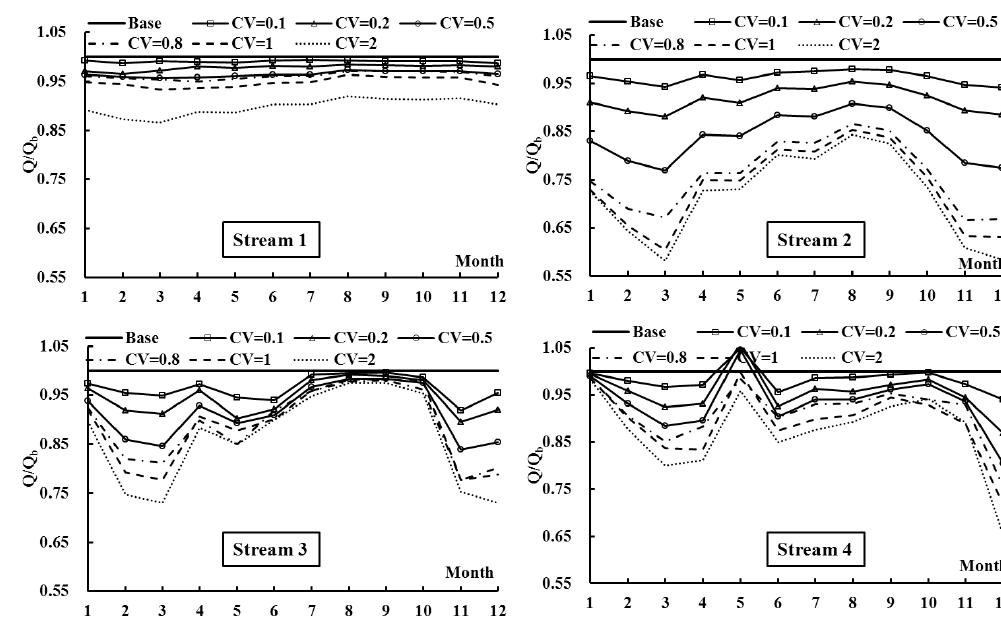
Figure 7. Aquifer–stream discharges of different streams from refined model.